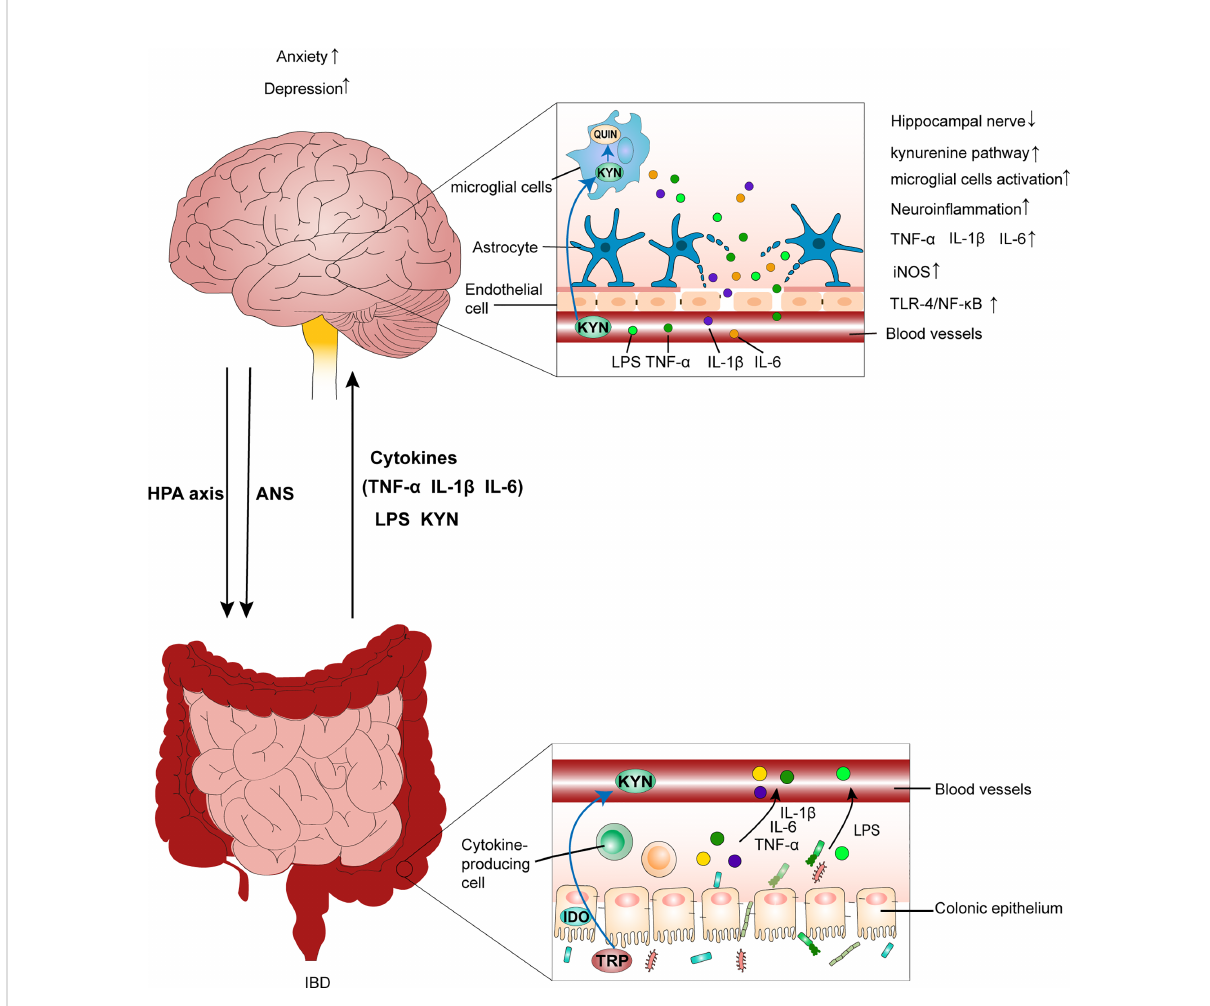
FIGURE 2 IBD leads to anxiety- and depression-like behavioral comorbidities by inducing neuroin fl ammation. Chronic psychological stress, such as anxiety and depression, aggravates colitis by activating the HPA axis and disrupting the ANS. This is accompanied by an increase in the production of LPS, pro-in fl ammatory cytokines (TNF- a , IL-1 b , and IL-6), and gut leak. Additionally, peripheral in fl ammation causes a decrease in tight junction protein expression between endothelial cells in the BBB. Then, the disruption of BBB integrity predisposes the translocation of circulating in fl ammatory mediators into brain tissues, which leads to the in fl ammatory response in the CNS by increasing IL-1 b , IL-6, and TNF- a levels, activating the TLR4/NF- k B in fl ammatory pathway, as well as increasing iNOS and nitrite levels in brain tissues. Further, circulating in fl